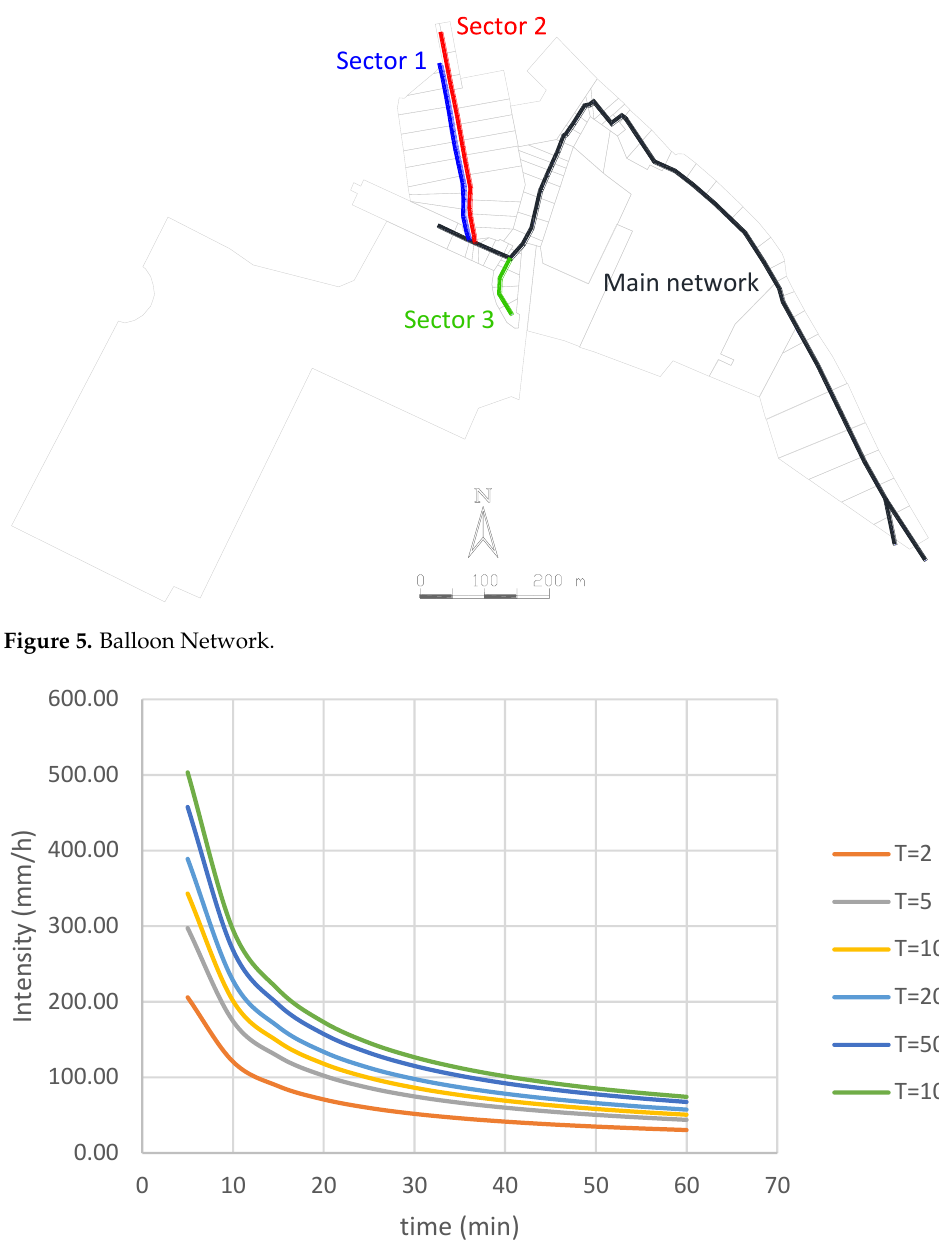
Figure 6. IDF Curves studied for Balloon network.